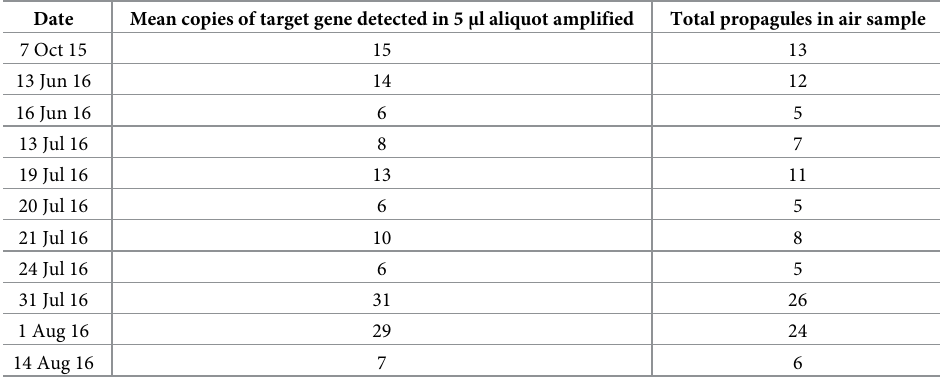
Table 3. Detection of Es . africanus propagules in daily air samples.